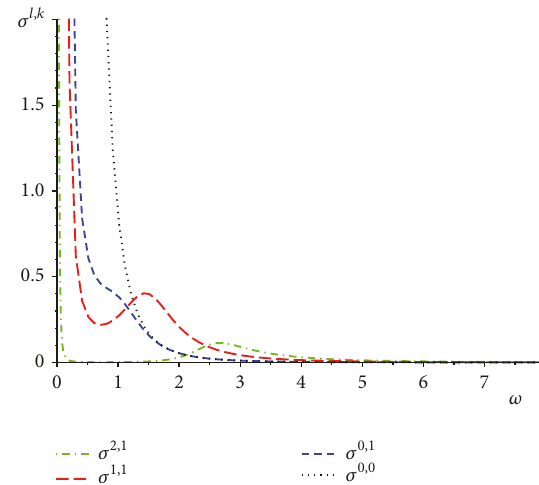
Figure 1: Plots of the ACS ( 𝜎 𝑙,𝑘 ) versus frequency 𝜔 . The plots are governed by (63). The configuration of the dilatonic 5𝐷 BS is as follows: 𝜇 = 3 and 𝑄 = 0.2